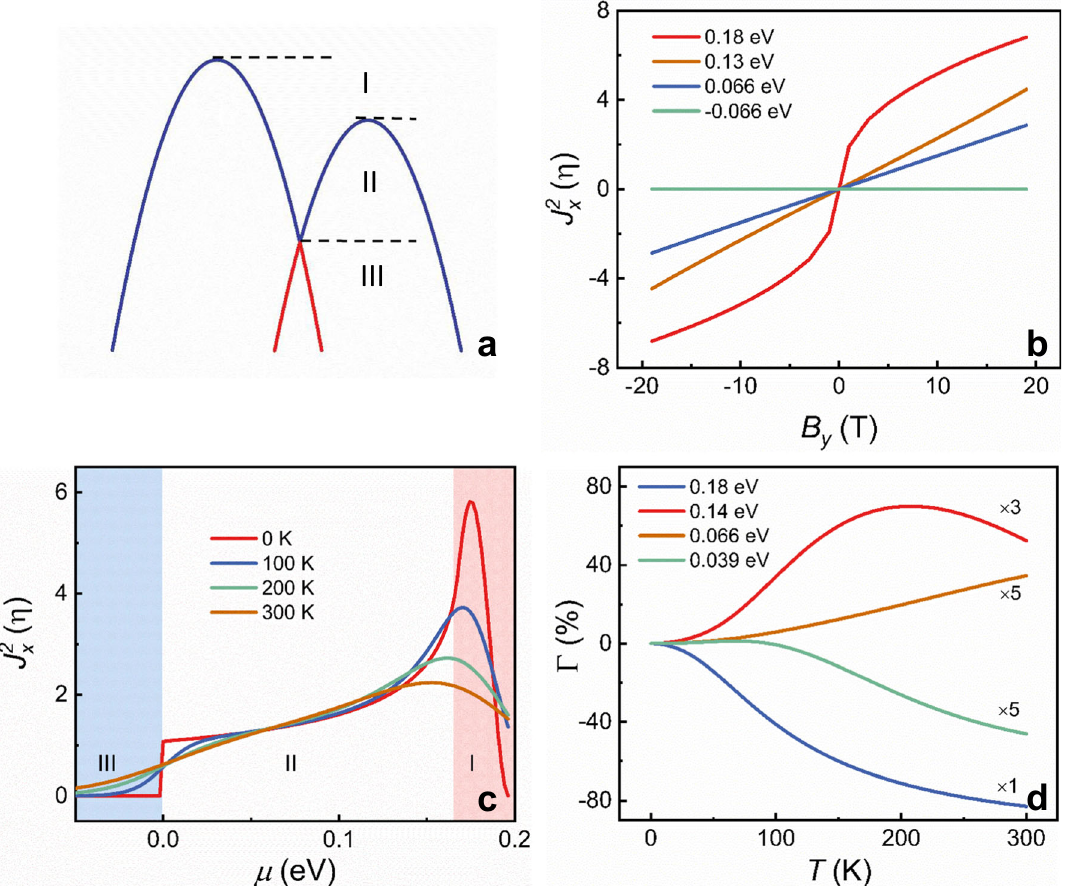
Fig. 4 Theoretical calculations for second-order charge current J 2 x . a Scheme of 2D Rashba-type bands under the in-plane magnetic fi eld B y . b The calculated J 2 x (in unit of η ¼ 0 : 5m (cid:3)(cid:1) 1 α (cid:1) 1 (cid:1) h (cid:1) 2 E (cid:1) 2 x e 3 τ 2 ) as functions of the applied magnetic fi eld B y at different Fermi level position at 0 K. c Evolution of J 2 x as functions of Fermi level position at B y = 10 T at various temperatures. The three-color codes correspond to the three energy regions in a . d Temperature dependence of Γ at various Fermi levels. For comparison, Γ is multiplied by different